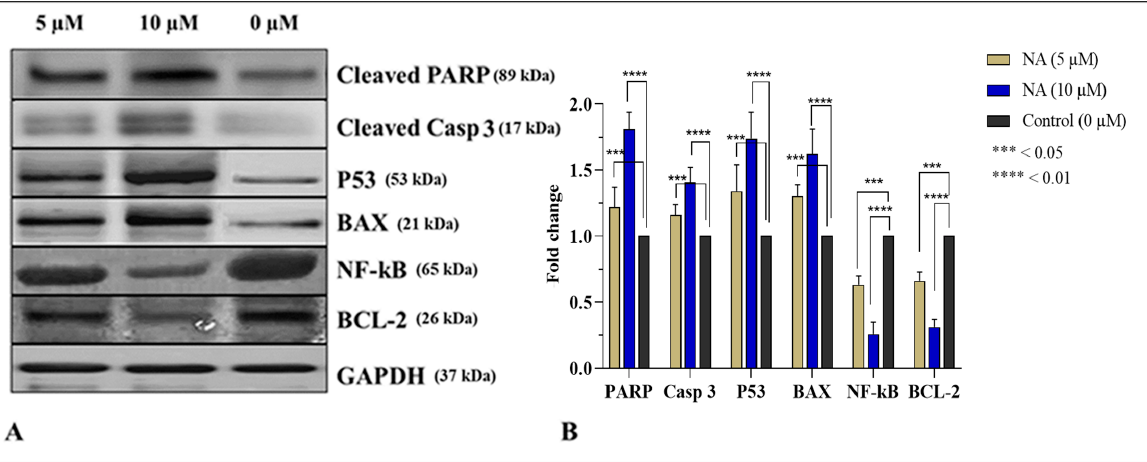
Figure 5. Western blot analysis of proteins associated with NA induced apoptosis. Note: Prostate cells and DU145 cells were treated with NA at concentrations of 5 µM and 10 µM for 48 h. ( A ) Data show increased cleavage of caspase 3 and downstream PARP, increased expression and upregulation of pro-apoptotic P53 and BAX, and decreased expression downregulation of anti-apoptotic NF- κ B and BCL2. GAPDH was used as a loading control. ( B ) Fold change in cleaved PARP, cleaved caspase 3, P-53, BAX, BCL-2, and NF- κ B expression after treating for 48 h with different concentrations of NA compared to control.